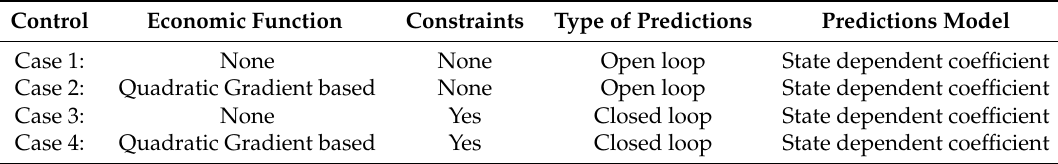
Table 5. Controllers